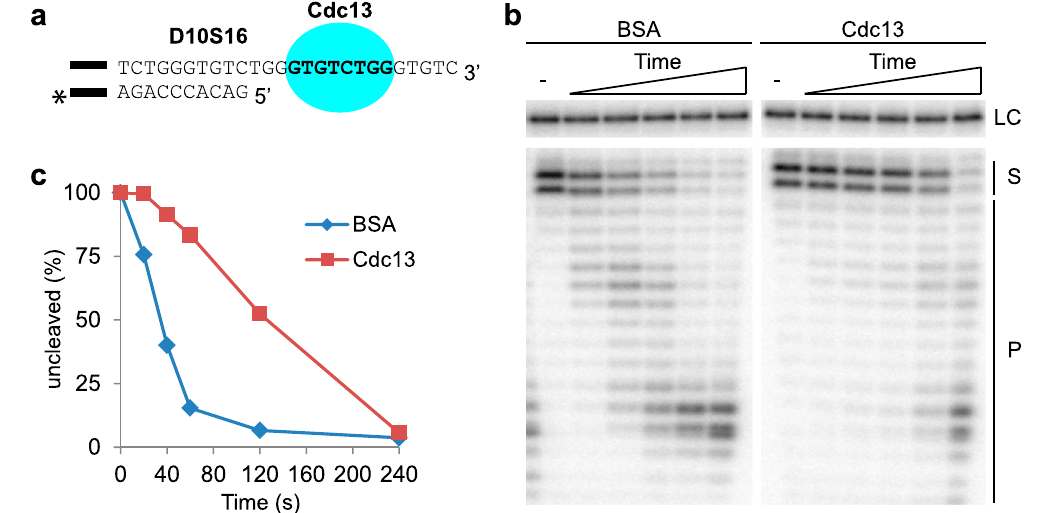
Figure 2. Cdc13 protects the telomere 5 ′ end when bound 3 nt away from the ds-ss junction. ( a ) D10S16 contains 10 bp of telomere dsDNA and a 16 nt ssDNA 3 ′ overhang. The Cdc13 MBS (bold text) is located 3 nt from the ds-ss junction. The black bar represents the 14 bp guide sequence (5 ′ -GTCACACGTCACAC-3 ′ ) used for ensuring proper annealing. “ * ” Indicates the radioactive label at the 3 ′ end of the C-strand, used for detecting the substrate and its degradation products. ( b ) Sequencing gel with the 5 ′ DEPA reaction products. D10S16 was either pre-bound by Cdc13 or incubated with non-DNA binding BSA protein. An aliquot was taken out before addition of λ -exonuclease (-), then λ -exonuclease was added and aliquots of the reactions were stopped at different time points (20; 40; 60; 120; 240 s). ( c ) Graph showing the quantification of the gel shown in ( b ). The amount of uncleaved substrate (S) relative the reaction start point was calculated by measuring